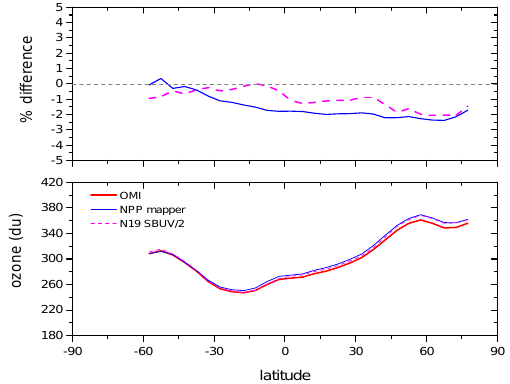
Figure 7. Latitude dependence of OMI relative to N19 SBUV/2 and the NPP OMPS mapper for June of